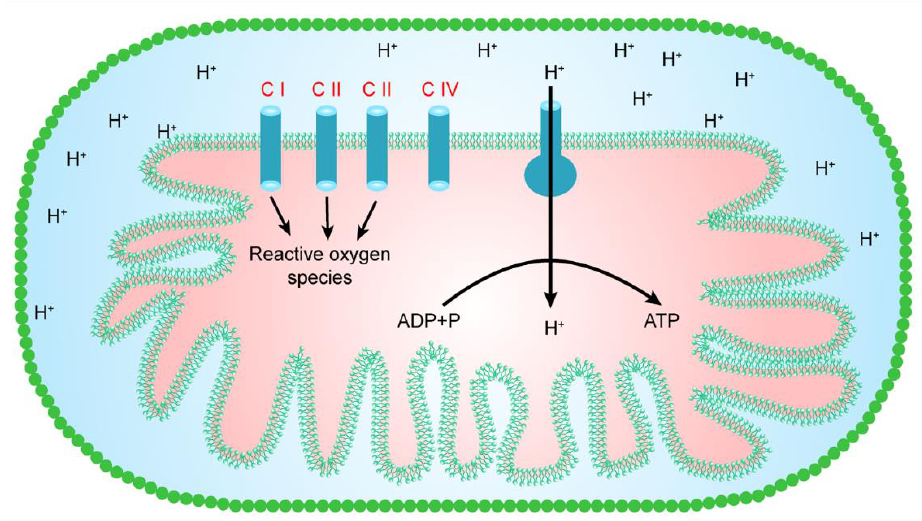
Figure 1. The major sites for the production of reactive oxygen species in a mitochondrion.